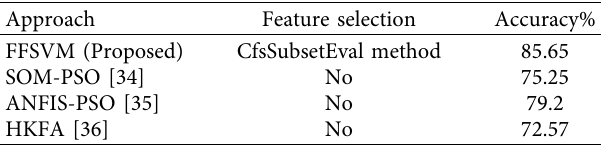
Table 8: Comparative analysis of the proposed method and the existing